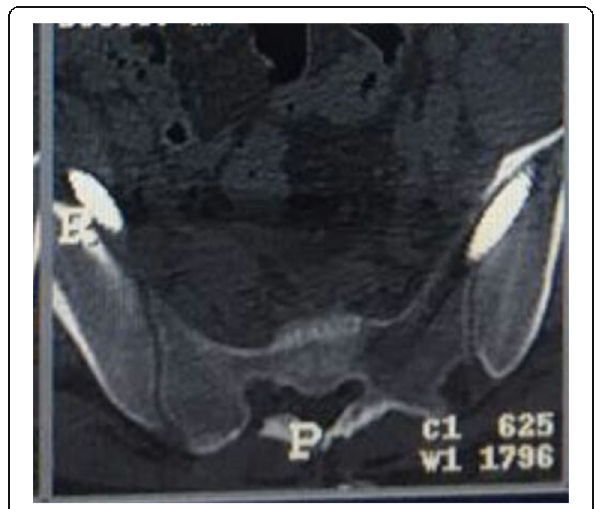
Fig. 3 Postoperative axial CT scan showing an anterior pelvic breach in a patient operated for lumbopelvic fixation due to L5-S1 discitis